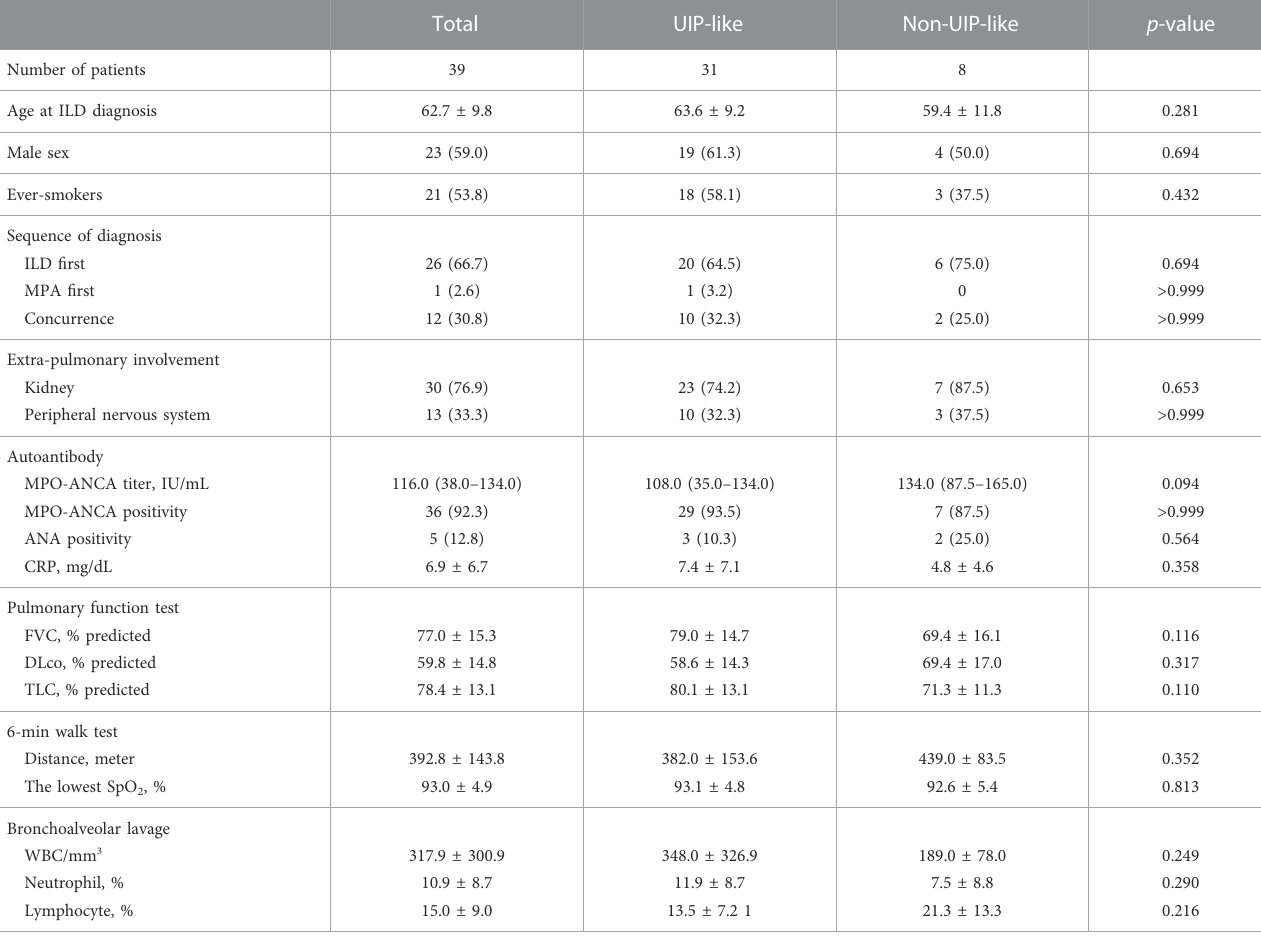
TABLE 3 Comparison of the baseline characteristics according to the HRCT patterns in patients with MPA-ILD. Total UIP-like Non-UIP-like